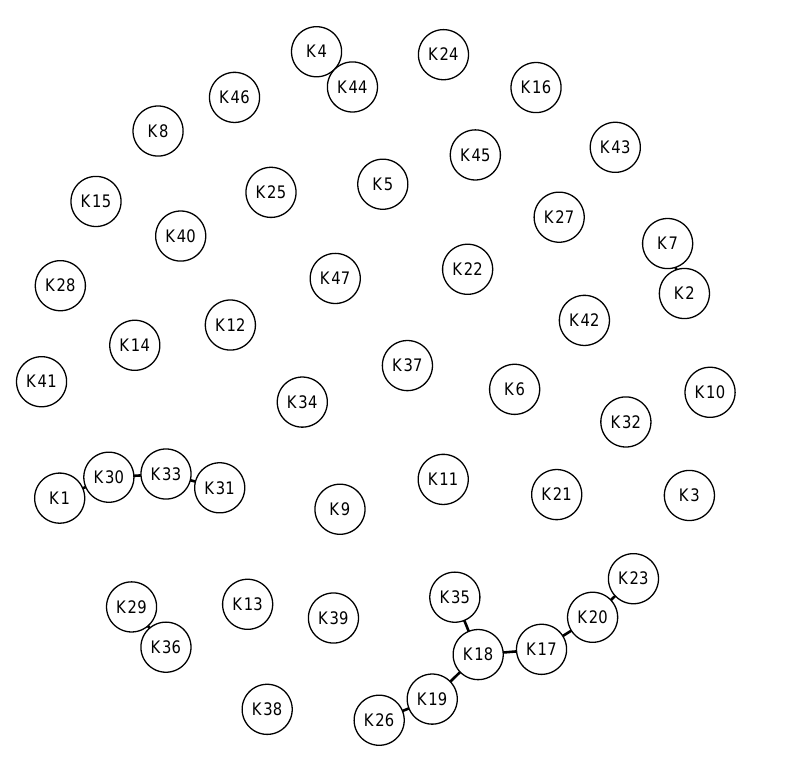
Figure 5. Mutual influence of system elements when using the composition T -norm Algebraic product and S -norm Maximum , and relevancy threshold of 0.7.